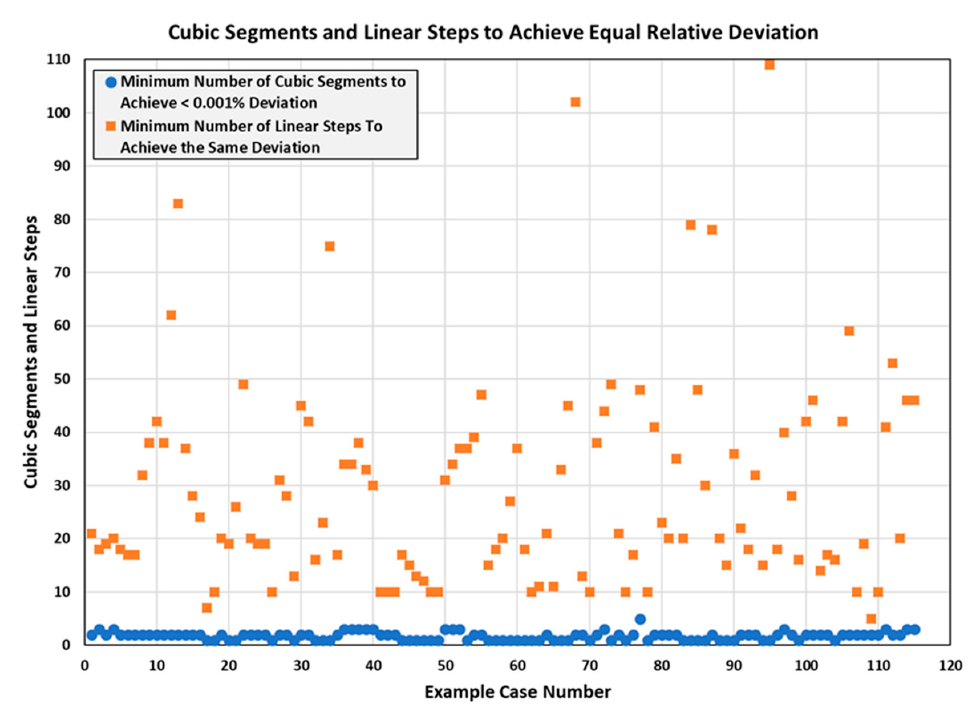
Figure 11. Cubic and linear polynomial solution results comparison for 115 example cases.